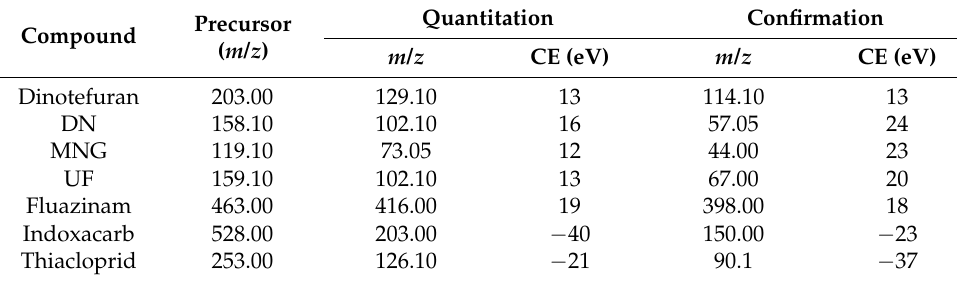
Table 2. Multiple reaction monitoring (MRM) conditions of each target pesticide for LC-MS/MS analysis.